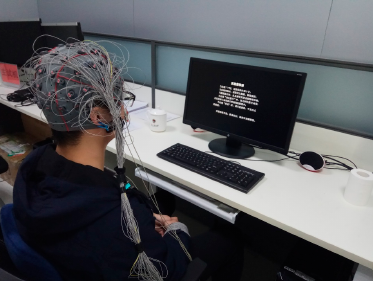
Figure 3. Experimental environment.